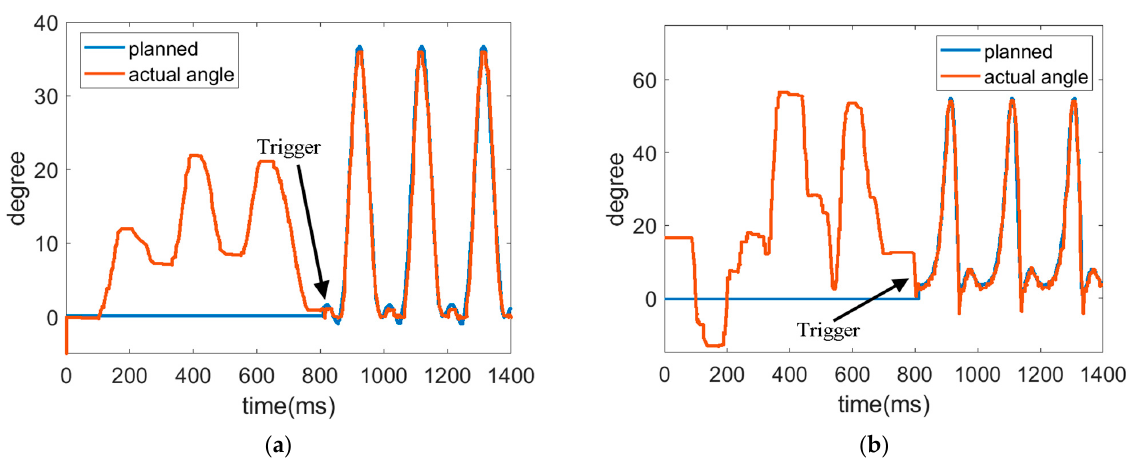
Figure 19. Trajectories of hip joint and knee joint when triggered by a foot touching the ground. ( a ) Trajectory of hip joint. ( b ) Trajectory of knee joint. Table 3. RMSEs of joint trajectories for different triggering times.